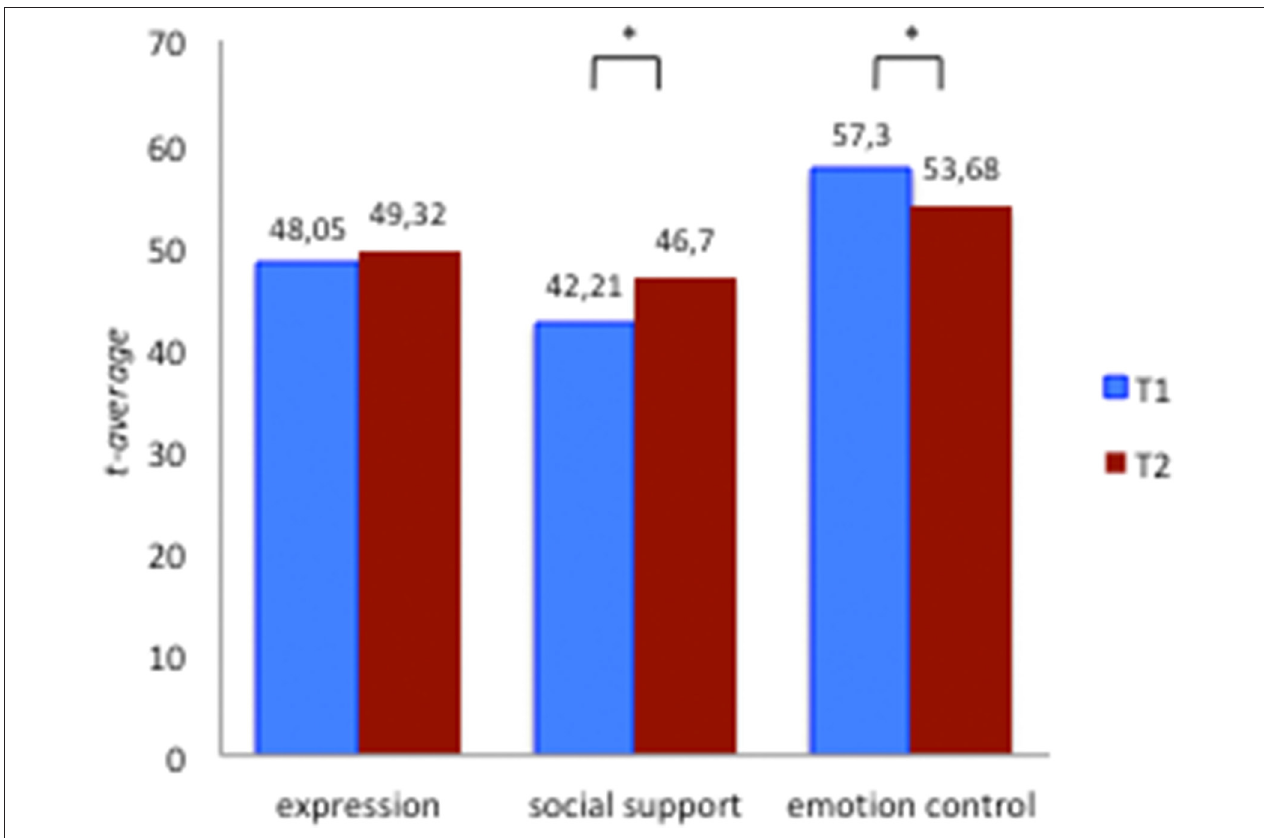
FIGURE 2 | FEEL-KJ additional scales. * symbol of